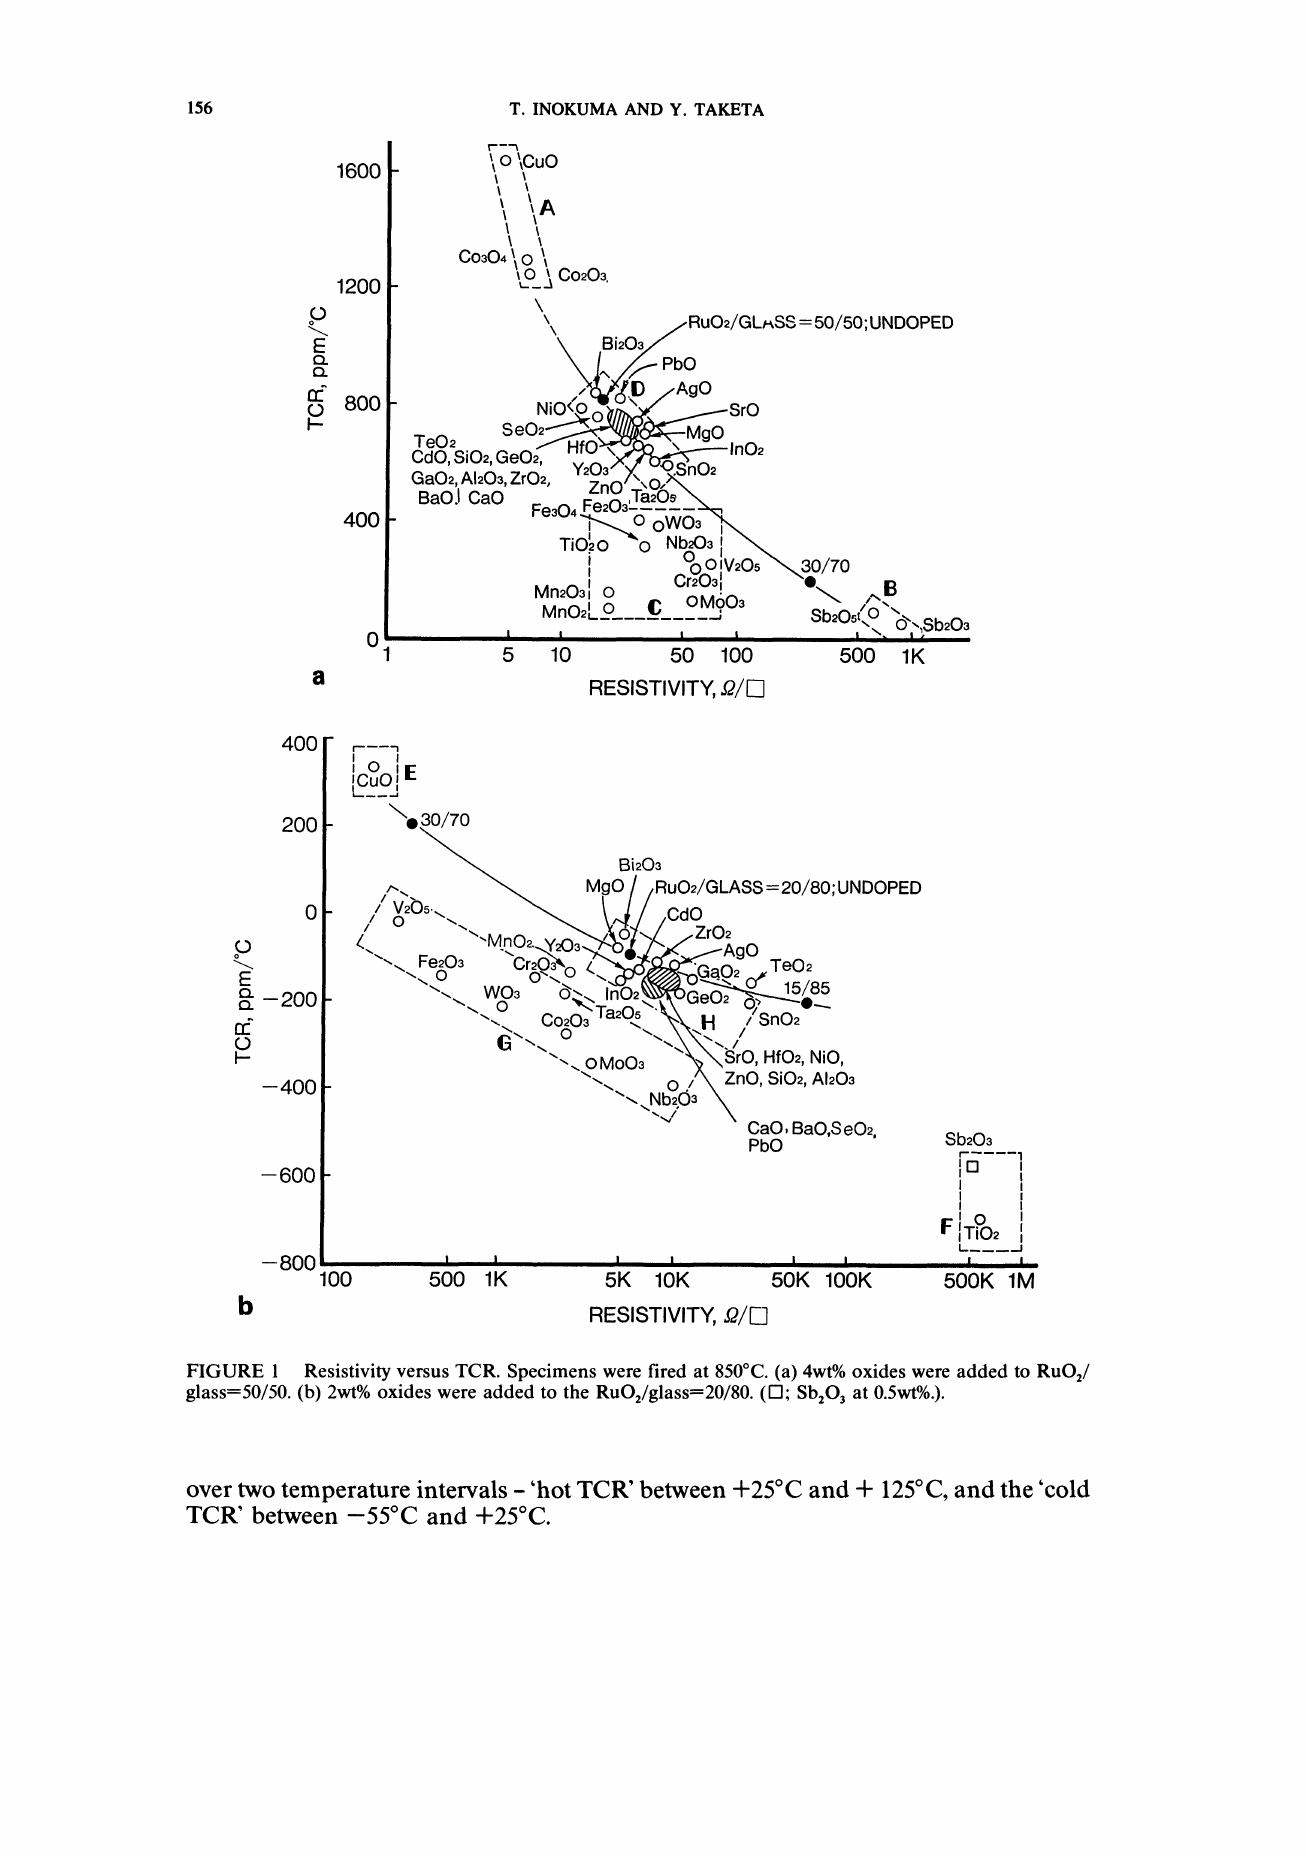
over two temperature intervals -’hot TCR’ between +25C and + 125C, and the ’cold TCR’ between -55C and